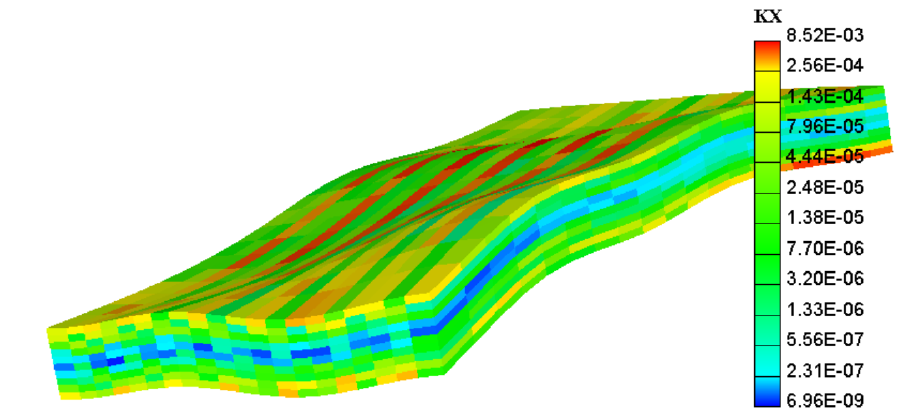
Figure 29. KX (mD) permeability in the pay-zone.